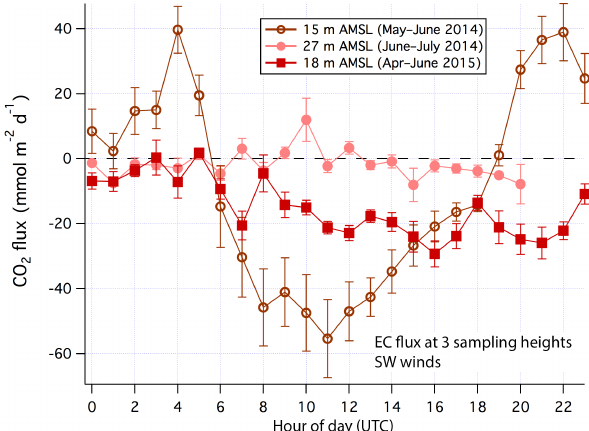
Figure 14. Diel variations in CO 2 fluxes at three sampling heights for south-westerly winds (180–240 ◦ ). Error bars correspond to standard errors within each hourly bin. At a sampling height of 15ma.m.s.l., large diel variability in CO 2 flux was observed most likely due to a local, terrestrial influence. Fluxes measured at ≥ 18ma.m.s.l. exhibit much less diel